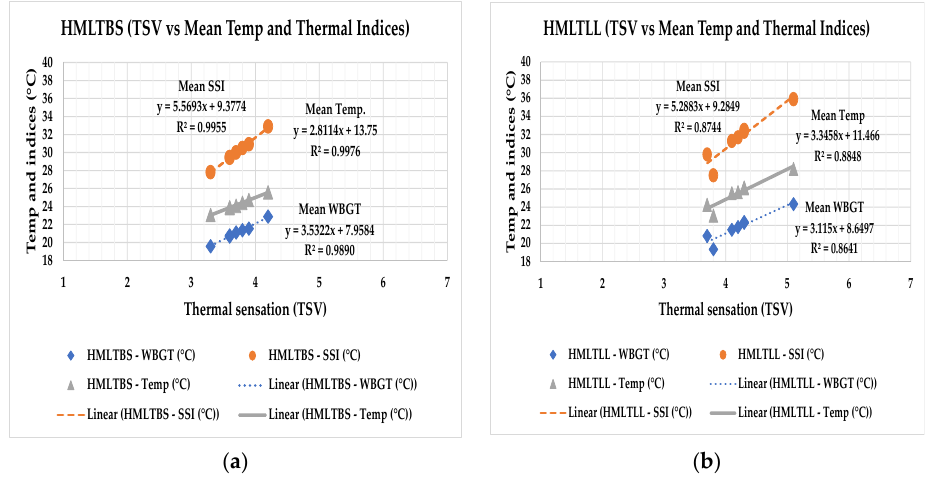
Figure 9. Correlations between the mean temperatures, thermal indices, and TSV in ( a ) HMLTBS and